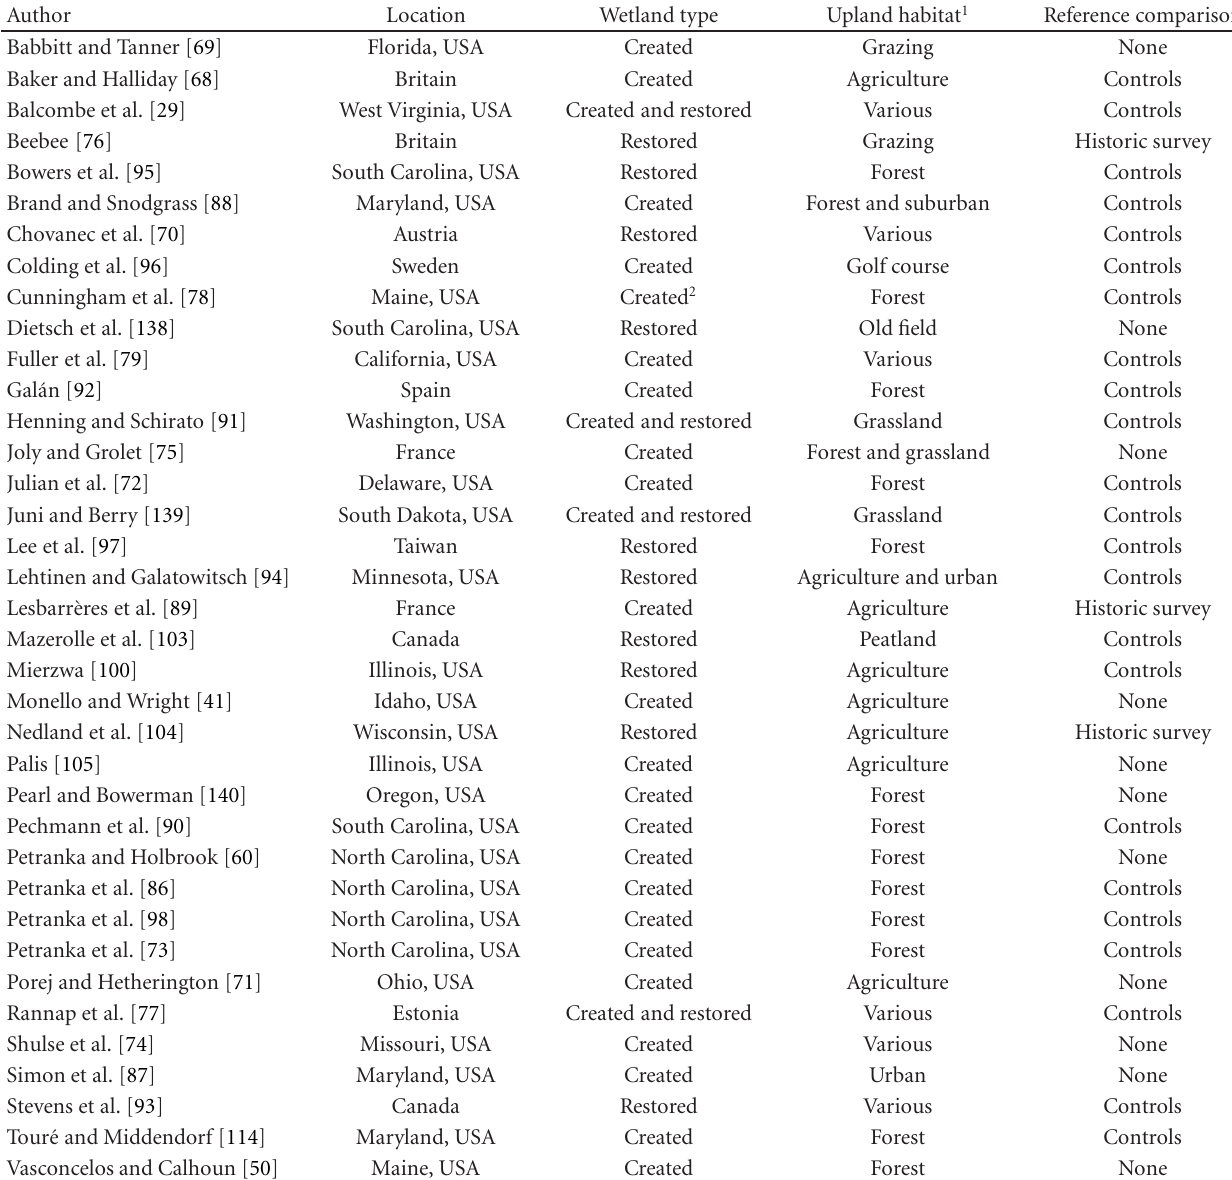
Table 1: Summary information for 37 peer-reviewed articles investigating amphibian use of created and restored